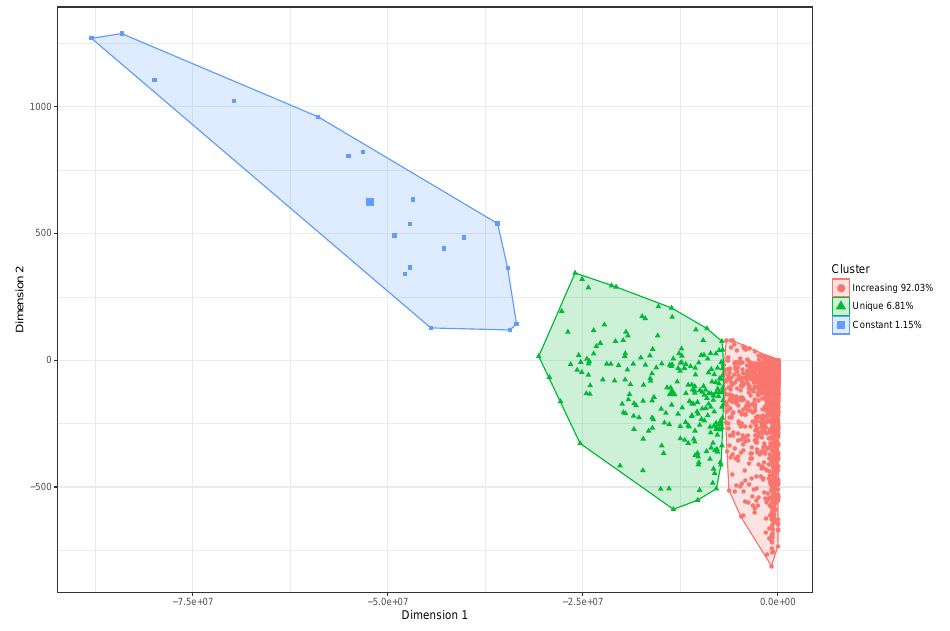
Figure 9. Segment classification through clustering for the logistic regression, after applying the filtering